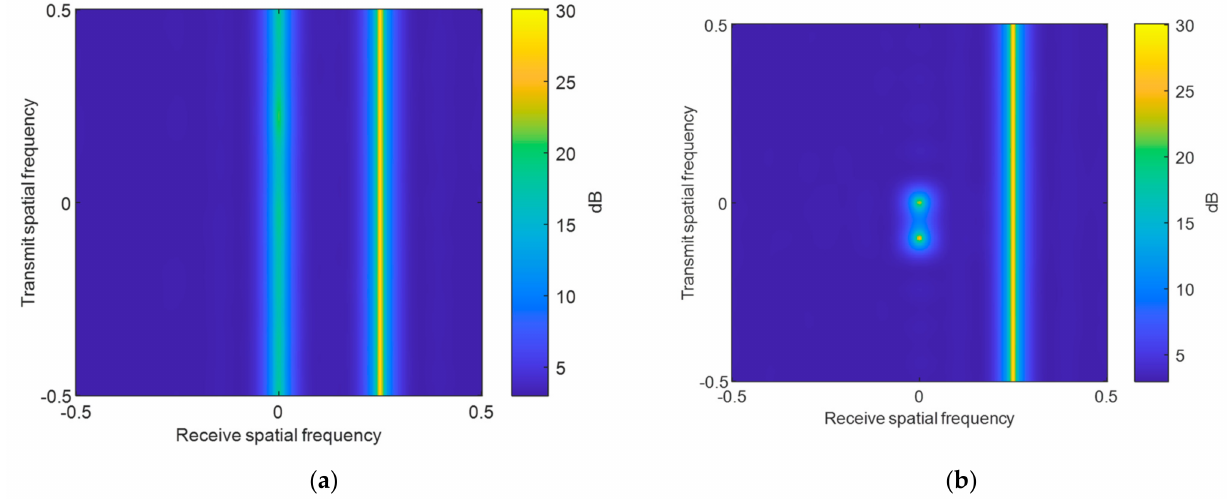
Figure 5. Capon power spectra of receive signal ( a ) before and ( b ) after